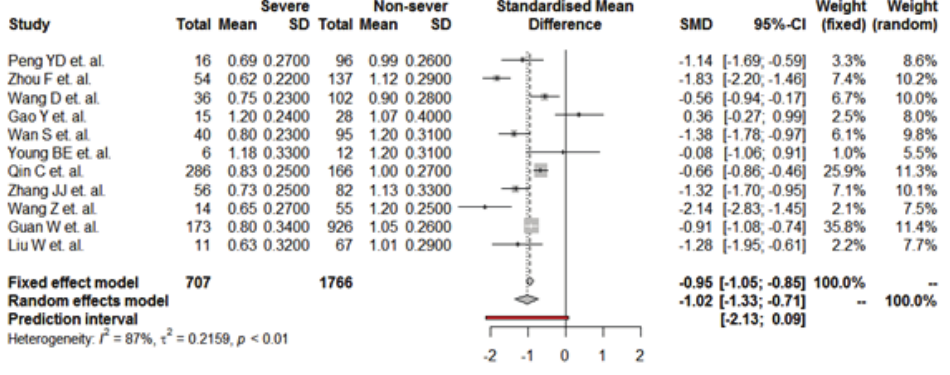
Figure 2: Pooled SMD of lymphocyte count estimates between the two groups of patients (severe and non-severe